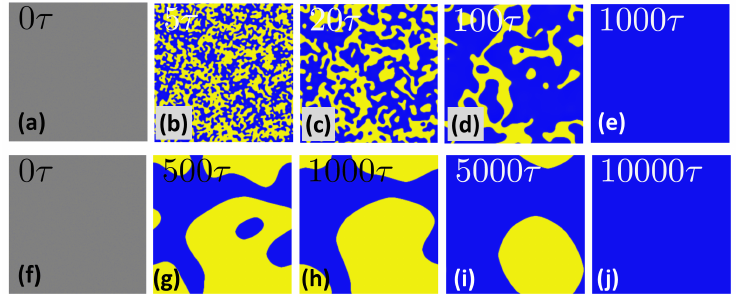
Figure 3. Snapshots of the morphologies of the A/B reacting system at different simulation time steps. The upper snapshots are obtained by Equations (23) and (24) of this work at ( a ) t = 0 τ , ( b ) t = 5 τ , ( c ) t = 20 τ , ( d ) t = 100 τ and ( e ) t = 1000 τ , while the bottom snapshots are obtained by the dynamical equations of previous works [23,24] at ( f ) t = 0 τ , ( g ) t = 500 τ , ( h ) t = 1000 τ , ( i ) t = 5000 τ and ( j ) t = 10000 τ . The numerical simulations are performed on a 256 × 256 lattice. φ A ( t = 0 ) = 1 − φ B ( t = 0 ) ≈ 0.5. D = 1.0, k 0 = 1.0, χ = 3.0, b A = 0.5, b B = 0.8 and ∆ τ = 0.05.